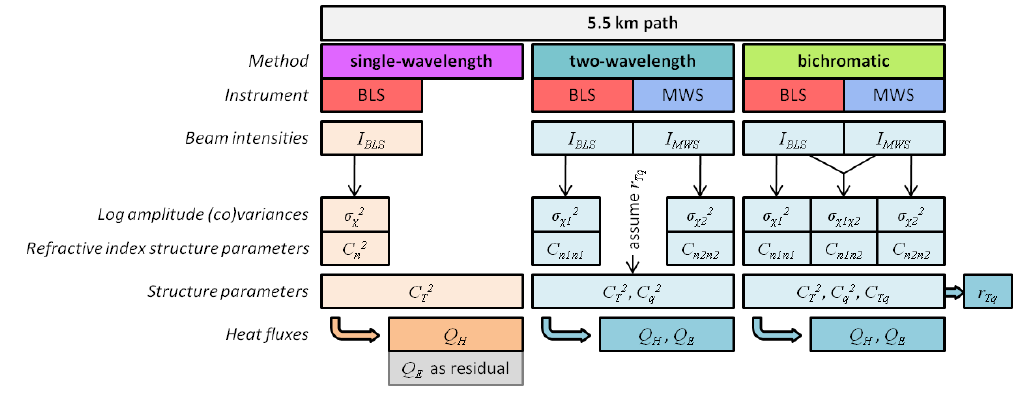
Figure 1. Methods to obtain heat fluxes from scintillometry as applicable to the experimental setup in Swindon. See Sect. 3 for details of the instrumentation, including an optical large aperture scintillometer (BLS) and a millimetre-wave scintillometer (MWS). Notation is defined in the